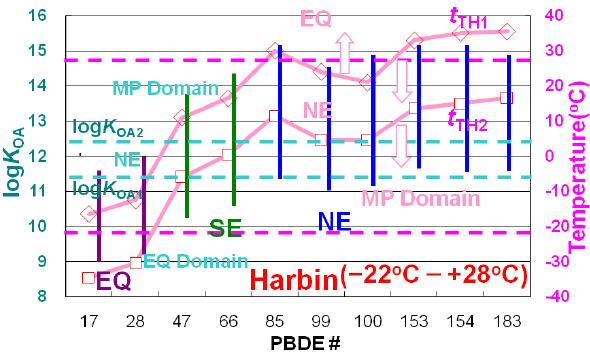
Figure 3. The range of log K OA (the left axis) and the threshold temperatures (the right axis) for 10 PBDE congeners in Harbin air at a temperature range of − 22 to + 28 ◦ C. The ranges of log K OA for the 10 PBDE congeners are given by the vertical bars. The two horizontal light blue dashed lines give the two threshold values of log K OA1 and log K OA2 , and the red diamonds and red squares present, respectively, the two corresponding threshold temperatures, t TH1 and t TH2 . The former divides the space of log K OA (the left axis) and the latter divides the temperature space (the right axis) into three domains: the EQ domain, the NE domain, and the MP domain. Thus, the PBDE congeners (homologues) in Harbin air can be segregated into three groups; BDE-17 and -28 (3-Br homologue) as equilibrium EQ group, BDE-47 and -66 (4-Br homologue) as semi-equilibrium SE group, and others (>4-Br homologues) as non- equilibrium NE group.